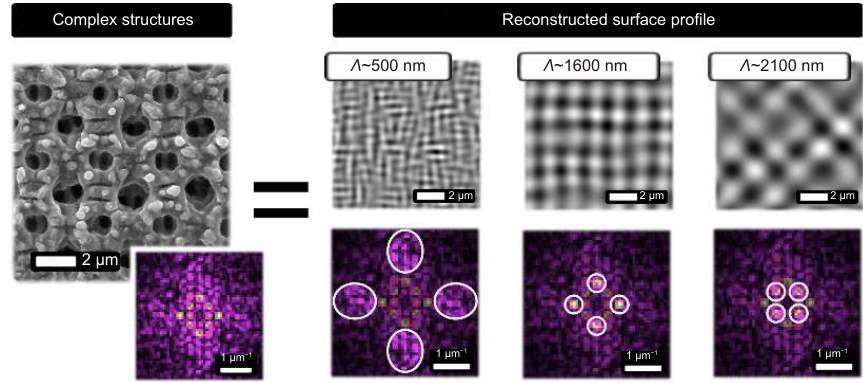
Fig. 6 | Complex structures generated with E tot = 70 μJ, NP = 100 with the D + G pulse sequence irradiation scheme. The SEM image is analysed with FFT and reconstructed surfaces comprising structures at different length scales are illustrated. The areas corresponding to the dif- ferent periodicities are highlighted in FFT